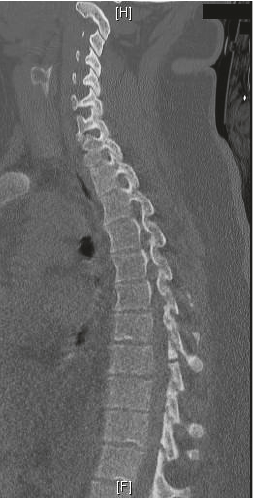
Figure 3: CT of the thoracic spine on presentation to the ED, showing a fracture through the lamina of